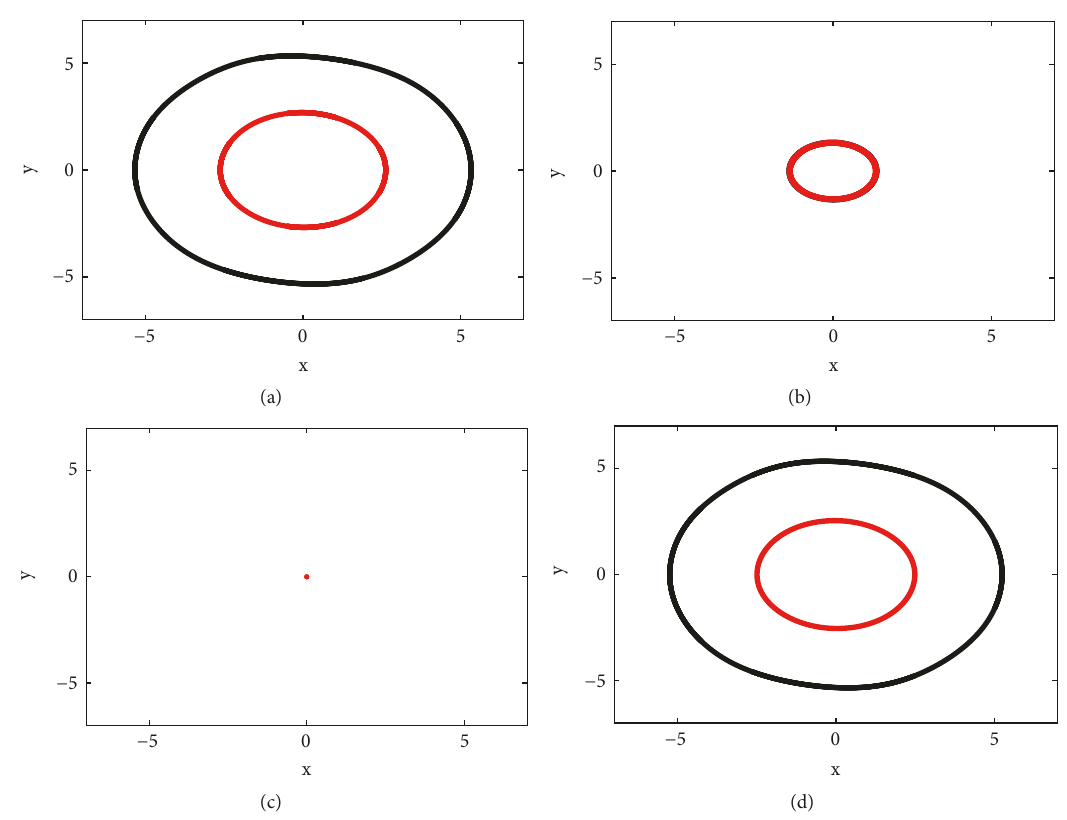
Figure 5: Phase plane plots corresponding to Figure 4(a). (a) 𝜏 = 0.2 , birhythmic oscillators; (b) 𝜏 = 1.16 , small-amplitude LC; (c) 𝜏 = 3.0 , stable steady state; (d) 𝜏 = 6.0 , birhythmic oscillators. The red line is for initial conditions 𝑥 = 0.1, ̇𝑥 = 0, V = 0.3 and the black line is for the initial conditions 𝑥 = 7.0, ̇𝑥 = 0, V = 0.3